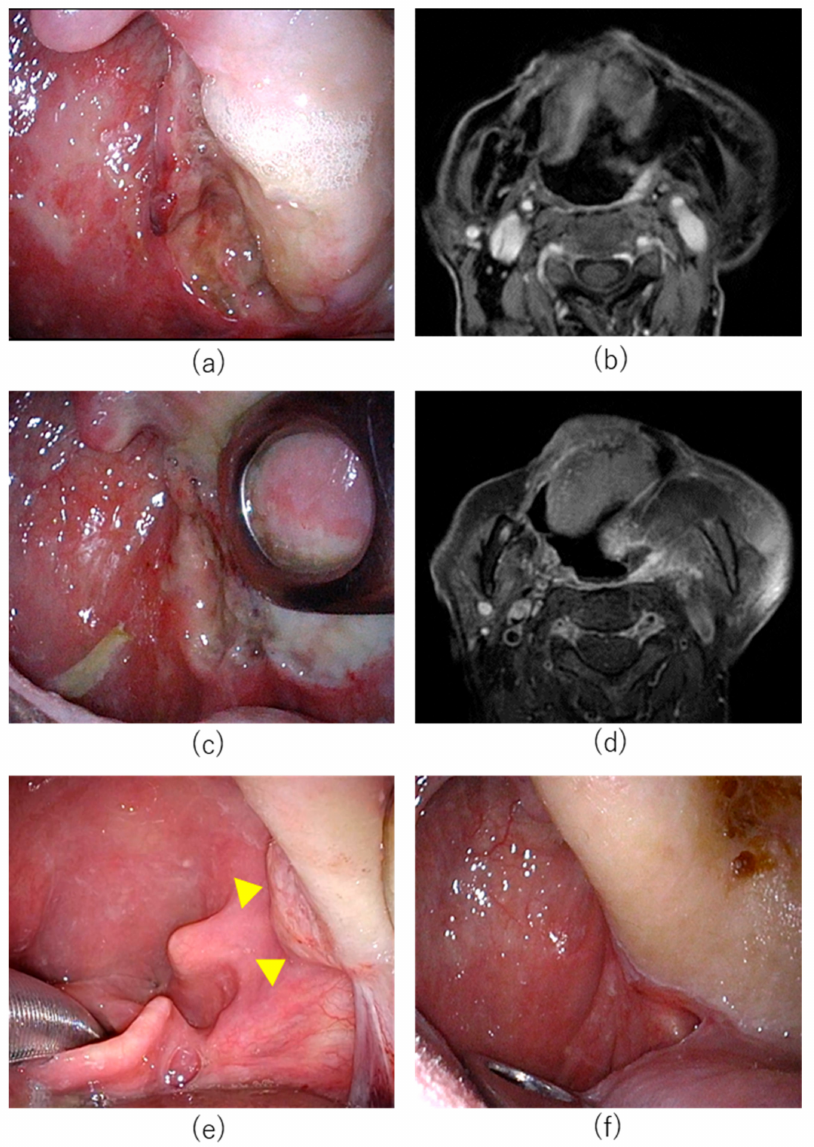
Figure 3. Posttreatment change after HN-PIT for Case 1. ( a ) Endoscopic image on postoperative day 9 after cycle 1. Ulceration was observed in the illuminated area. ( b ) MRI image after cycle 1. ( c ) Endoscopic image on postoperative day 6 after cycle 2. ( d ) MRI image after cycle 2. ( e ) Intraoperative image of the tumor (arrowheads) before transoral resection. ( f ) endoscopic image on postoperative 4